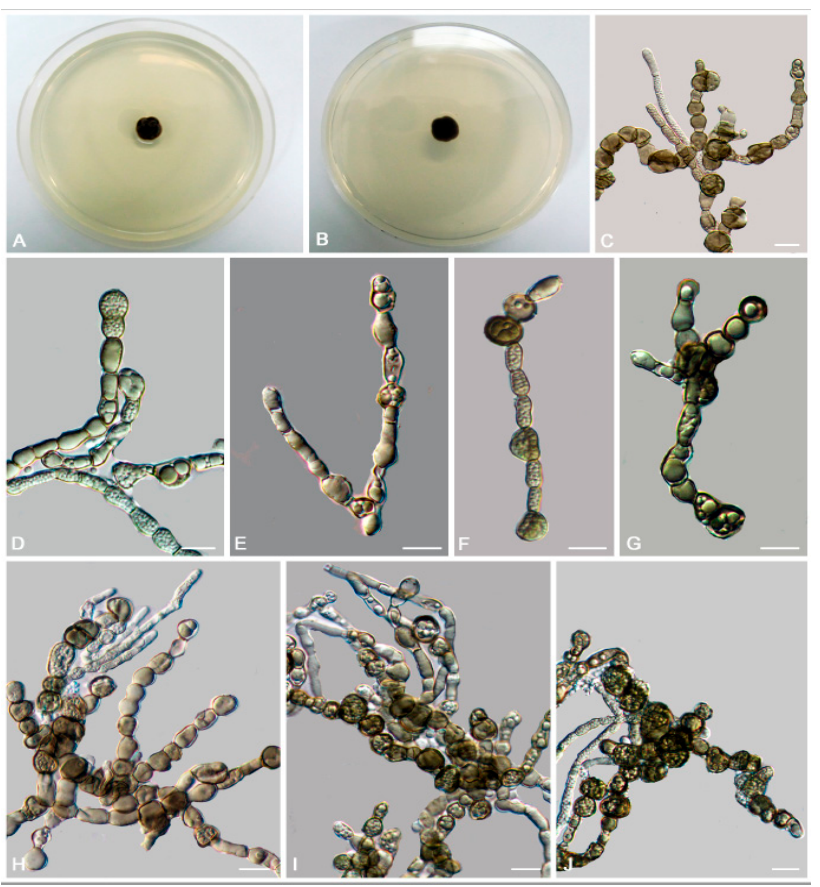
Figure 11. Knufia separata (CGMCC 3.17337). ( A , B ) Colony forward and reverse after 4 weeks on MEA. ( C – E ) Differentiated hyphae. ( F , G ) Swollen cell. ( H – J ) Dark pigmented multicellular bodies. Scale bars: ( C – J ) = 10 μ m.